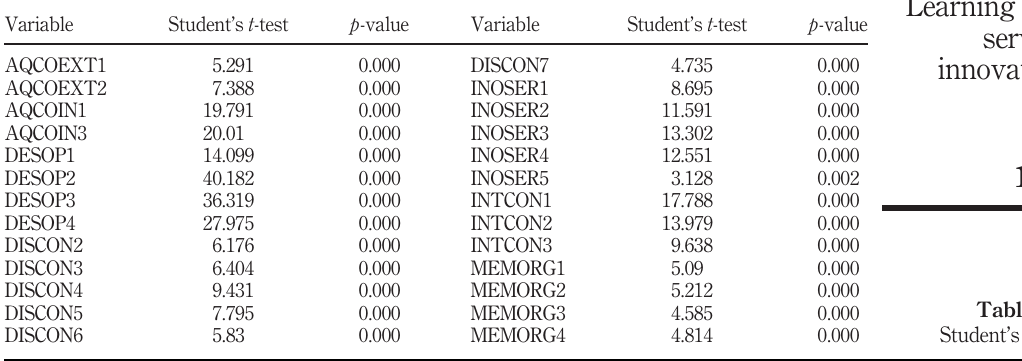
Table III. Student ’ s t -test